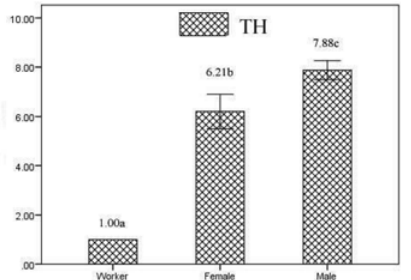
Fig.8 . relative expression profiles (± standard error of the mean; n=3) for PvtH in the heads of different castes. All expression levels are shown relative to the expression level in the heads of workers. Means followed by the same letter are not significantly different